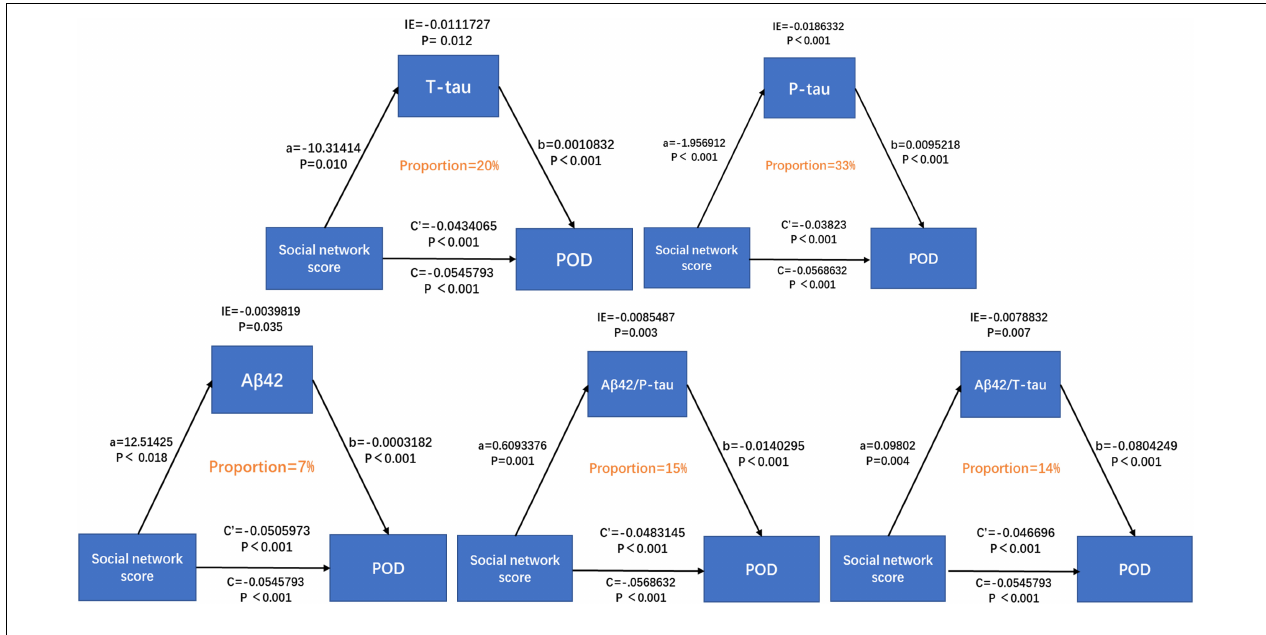
FIGURE 4 | Mediation